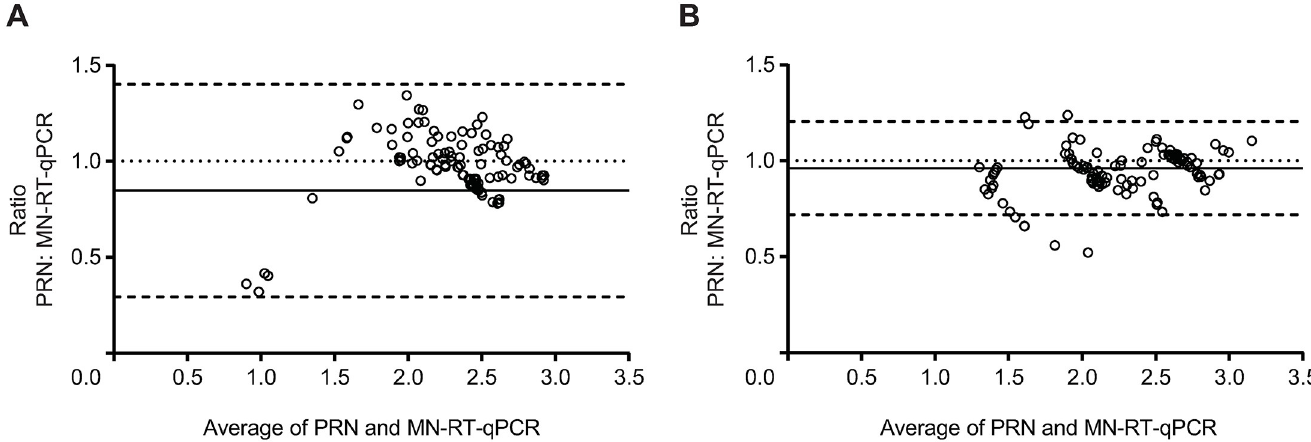
Fig 5. Bland-Altman plots of PRN vs. MN-RT-qPCR assays. Neutralization assays were performed with low-passage Edmonston MV using a panel of human serum samples (N = 136). The concentrations were log transformed prior to the analysis. The ratios of PRN to MN-RT-qPCR were plotted against the average of PRN and MN-RT-qPCR. (A) Analysis of PRN ND 50 vs. MN-RT-qPCR ND 90 values. (B) Analysis of PRN ND 90 vs. MN-RT-qPCR ND 90 values of measles neutralizing antibodies in milli-International units. The lines of no bias (dotted line at y = 1), mean bias (solid line), and lower and upper limits of agreements (dashed lines) are